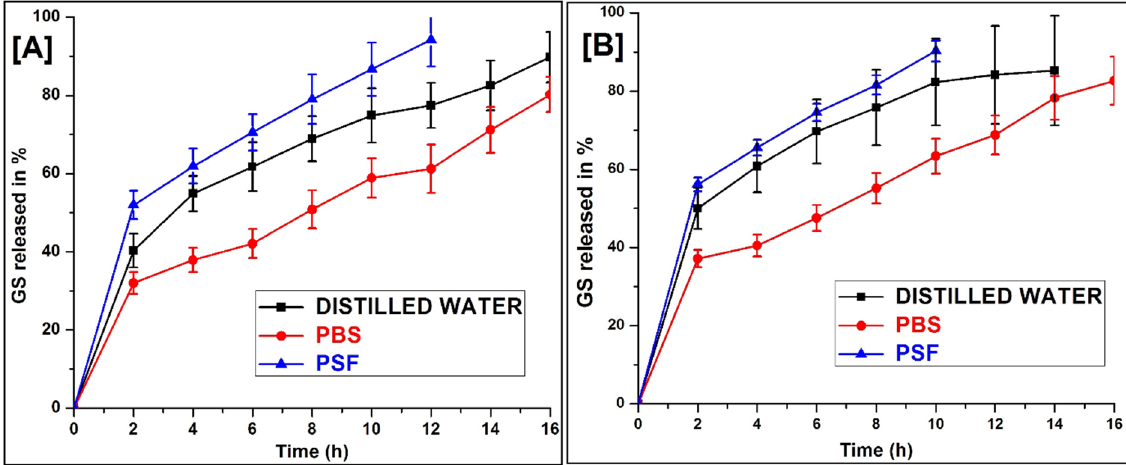
Figure 6. In vitro of GS release from ( A ) 1:3, and ( B ) 1:4 scaffold in different dissolution medium (Mean ± SD, n = 3).